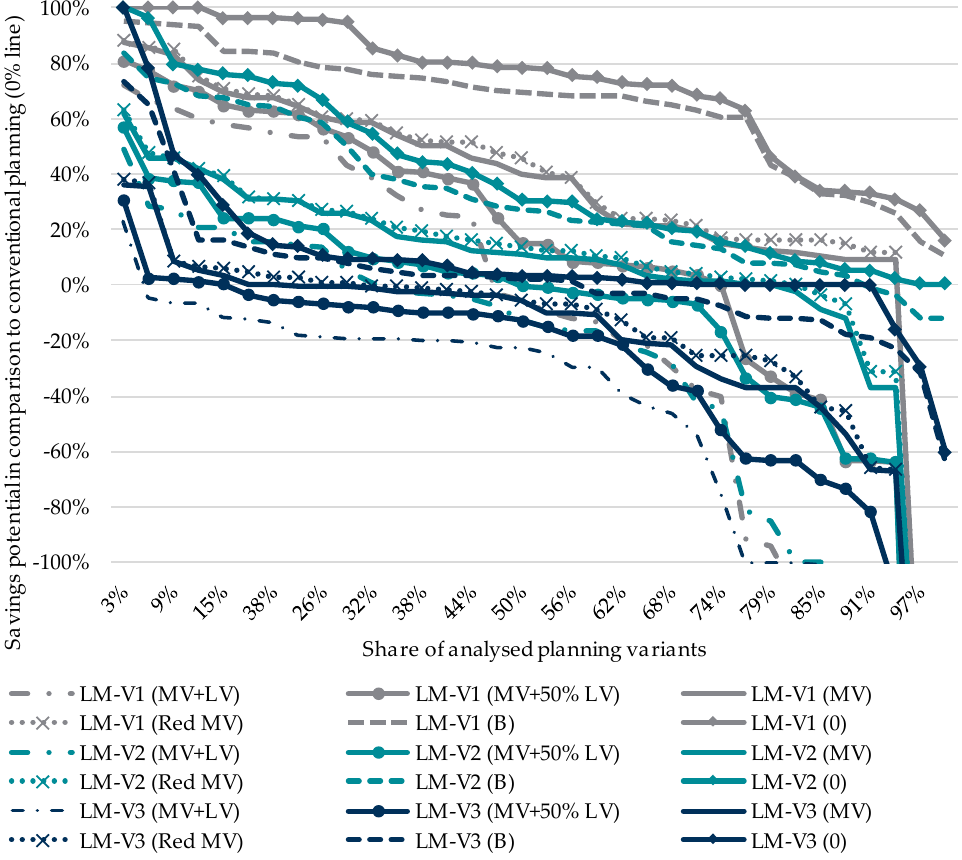
Figure 18. The savings potential for the three load management variants with the six layouts in comparison to conventional planning over all analyzed variants based on [59].